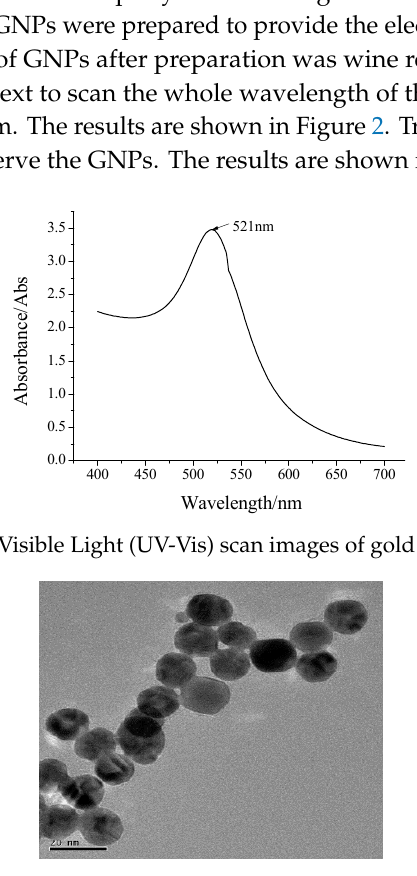
Figure 3. TEM representation images of GNPs (145,000×).